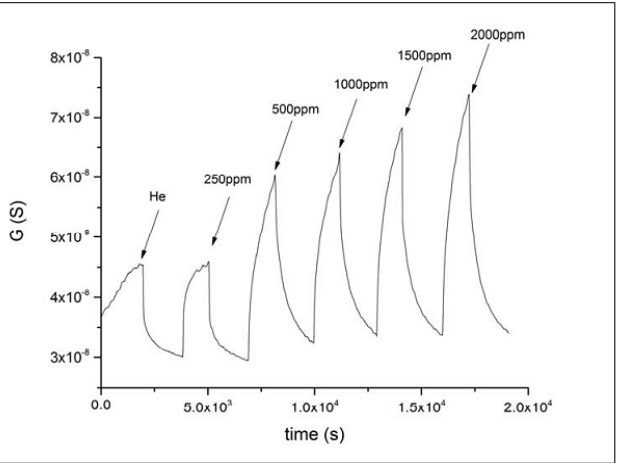
Figure 7. TiO 2 sensor response/recovery characteristics, at a working temperature T w = 400 °C, from ref. [31]. Ref.